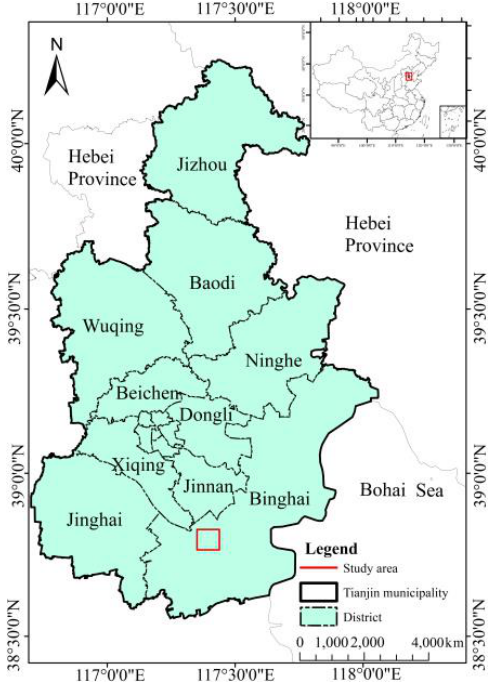
Figure 1. Location of the experimental site. Table 1. Soil physical properties of the 0 – 30 cm profile before experiments.